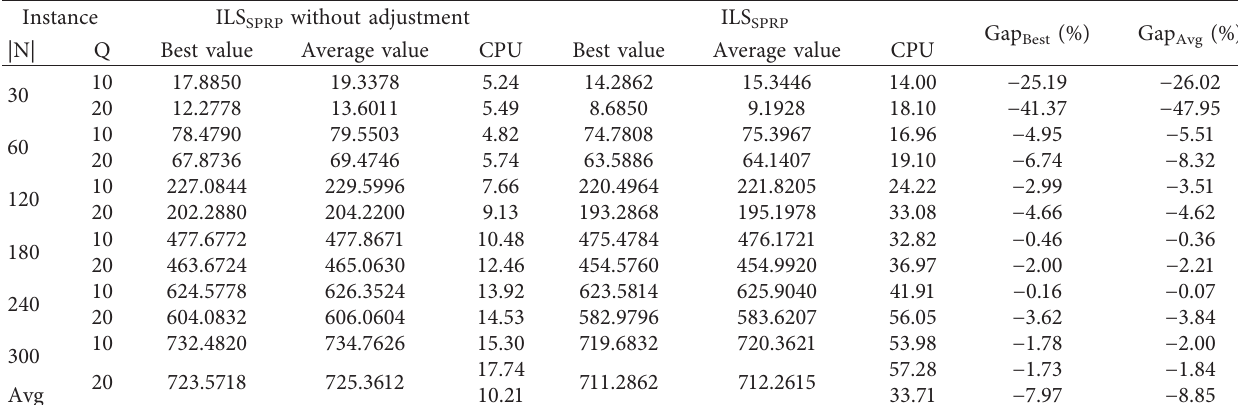
Table 8: Result comparison of ILSSPRP with and without the adjustment operator ( T �